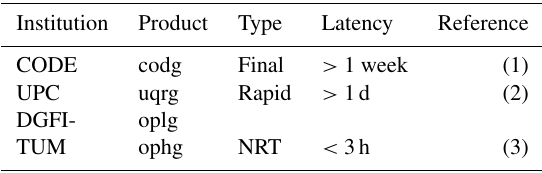
Table 2. List of GIM products used in this paper. Information on names, types and latencies are taken from the following references: